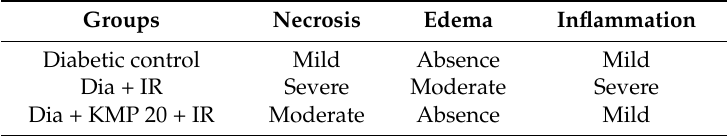
Table 5. Effect of kaempferol on histopathological evaluation. The changes are ranked as: (Absence)